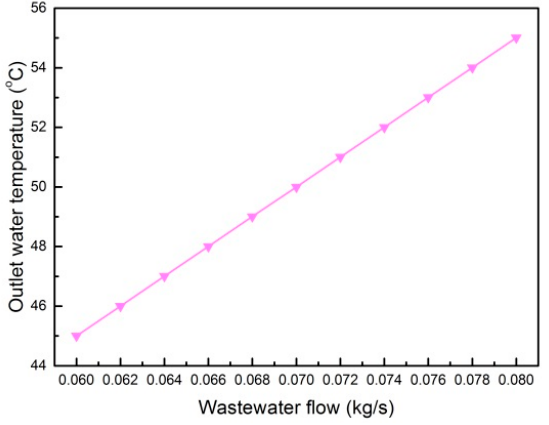
Figure 8. Influence of wastewater flow rate on outlet water temperature.